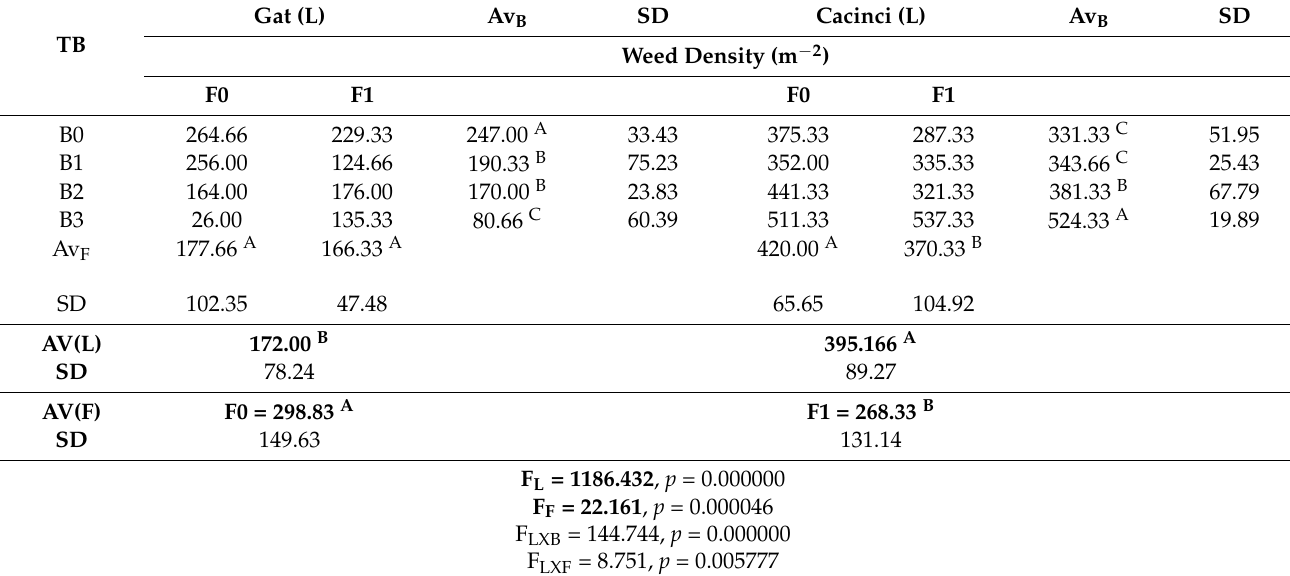
Table 6. Biochar and fertilization effects on weed density (m − 2 ).